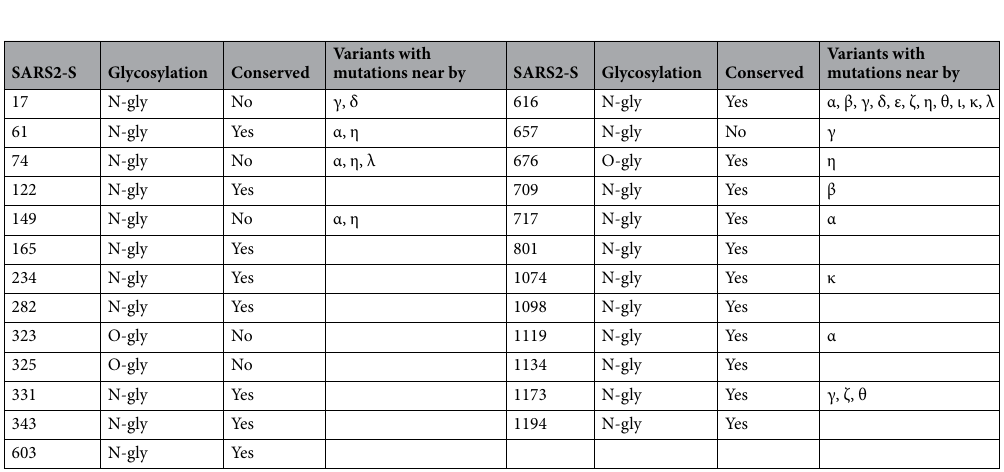
Table 4. Conservation of the glycosylation sites of SARS2-S. Most of the glycosylation sites reported from SARS2-S are shared with all the ACE2 binding sequences except for 6 residues 4 Arg, 1 Thr and 1 Ser. All variants of concern present mutations near at least one unique glycosylated residue.